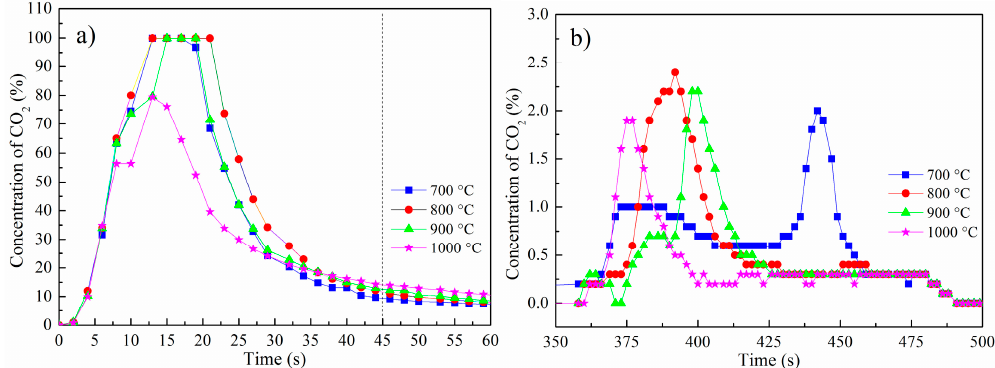
Figure 5. CO 2 concentration for ( a ) the reduction reaction process between Fe 2 O 3 /Al 2 O 3 and CO in the FR and ( b ) the regeneration reaction process between the reduced Fe 2 O 3 /Al 2 O 3 and air in the AR, under various temperatures.